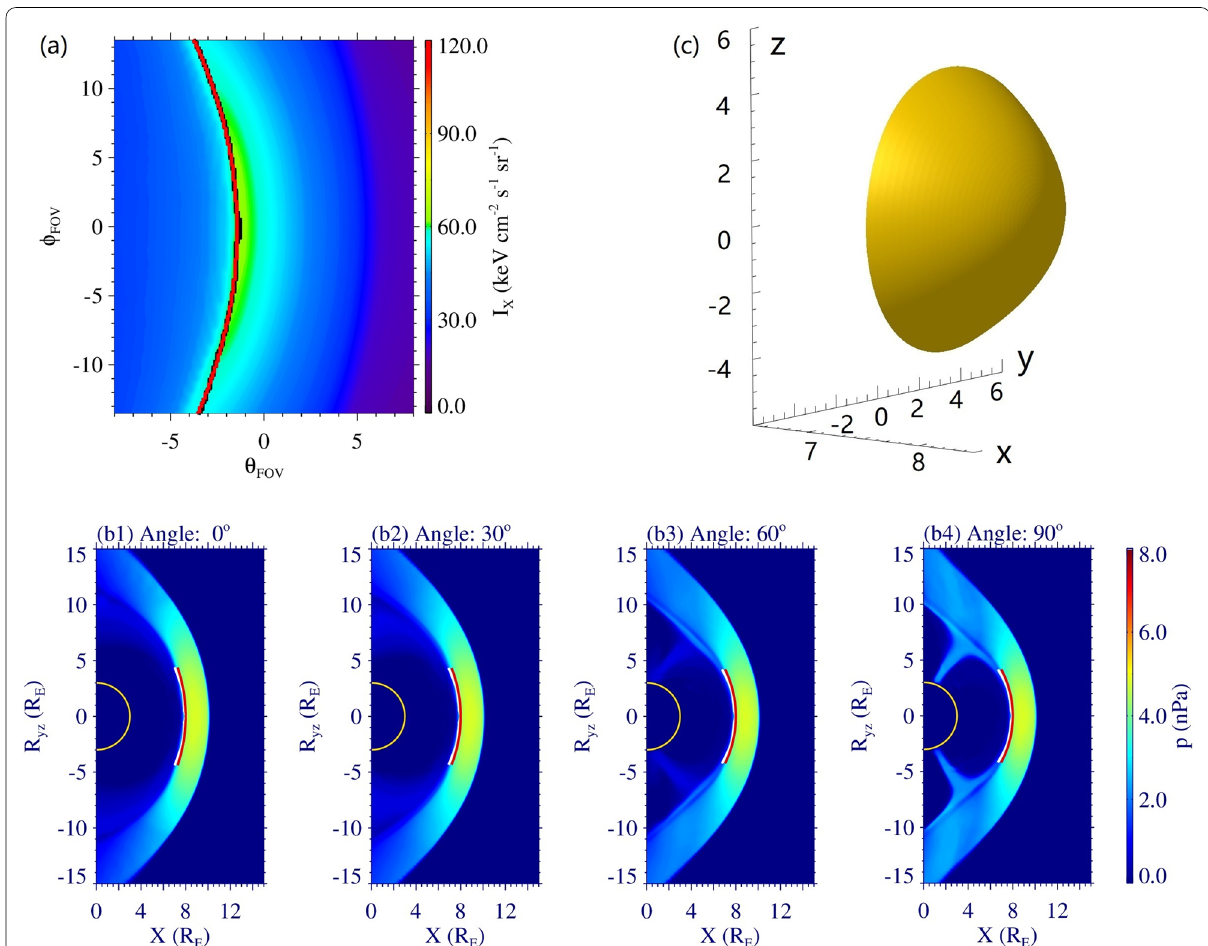
Fig. 7 Validation of TFA using MHD simulations. a The simulated soft X-ray image ’observed’ by SMILE; b the reconstructed magnetopause; c 2D views of the reconstructed magnetopause are in red curves, along with the original MHD boundary in white curves. Contours show plasma thermal pressure in planes rotating around the x-axis by 0 ◦ , 30 ◦ , 60 ◦ , and 90 ◦ , respectively, with 0 ◦ indicating the equatorial plane (Figure adapted from Sun et al.